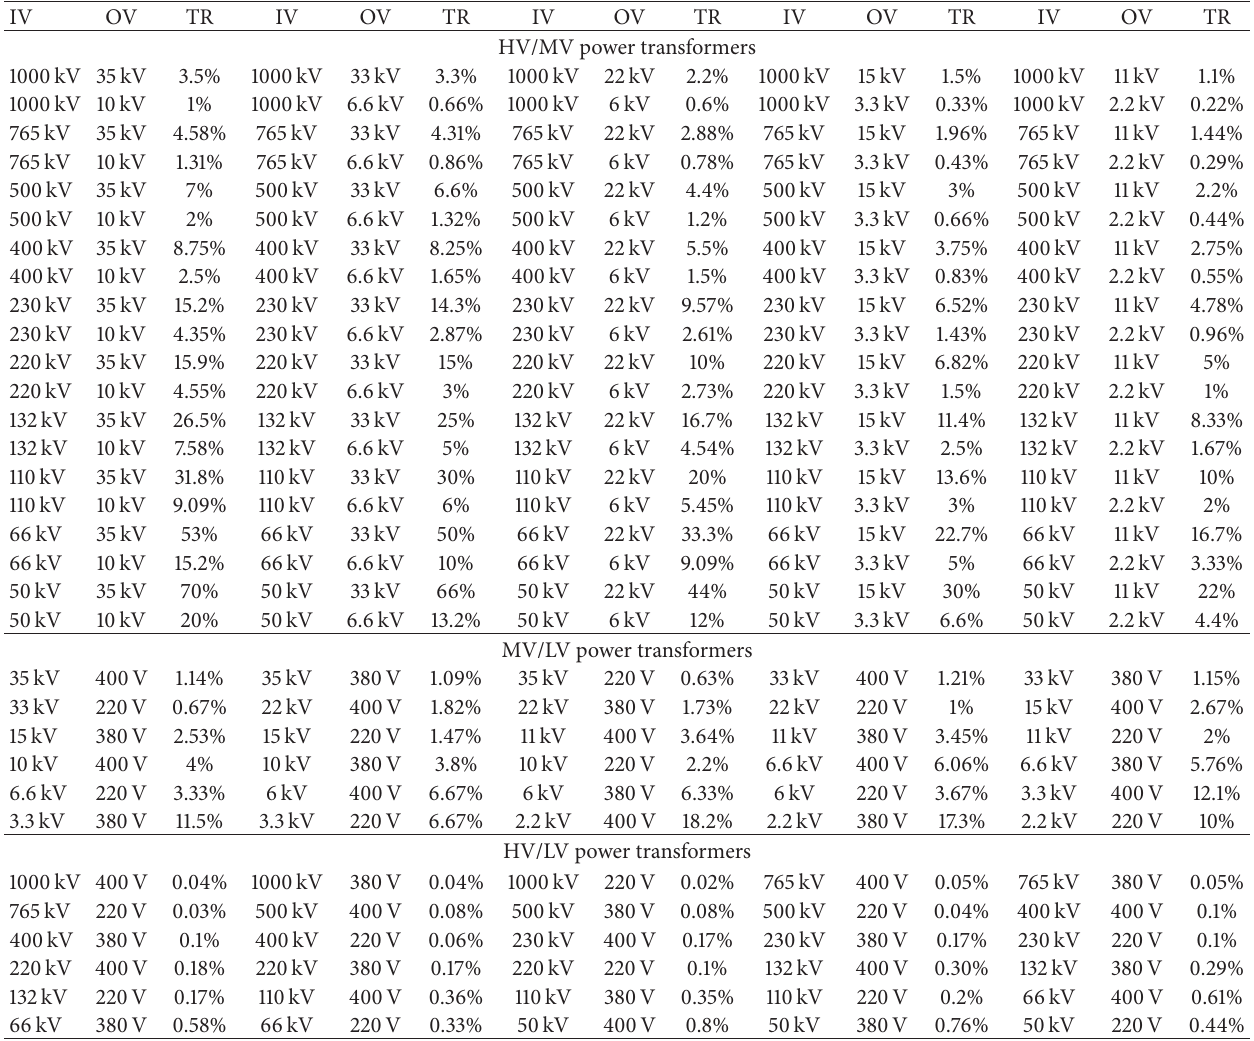
Table 4: Operation characteristics of HV/MV, MV/LV, and HV/LV power